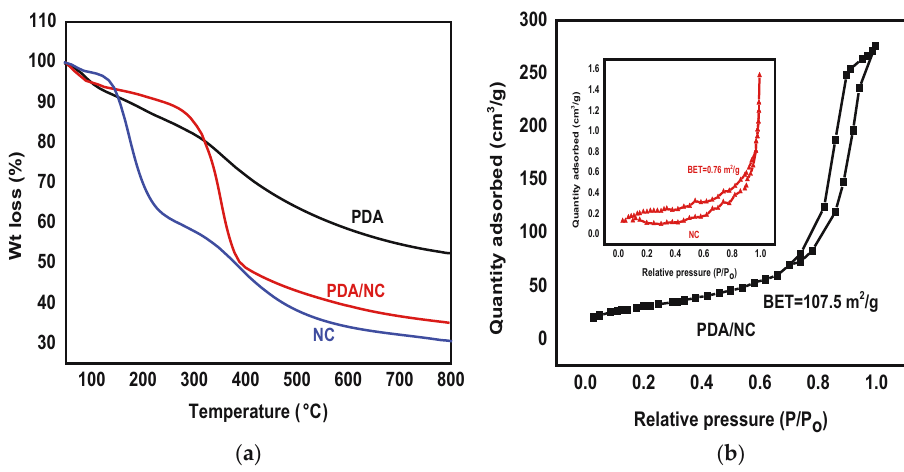
Figure 3: TGA ( a ) and nitrogen adsorption – desorption isotherm ( b ) of synthesized NC, PDA, and PDA/NC